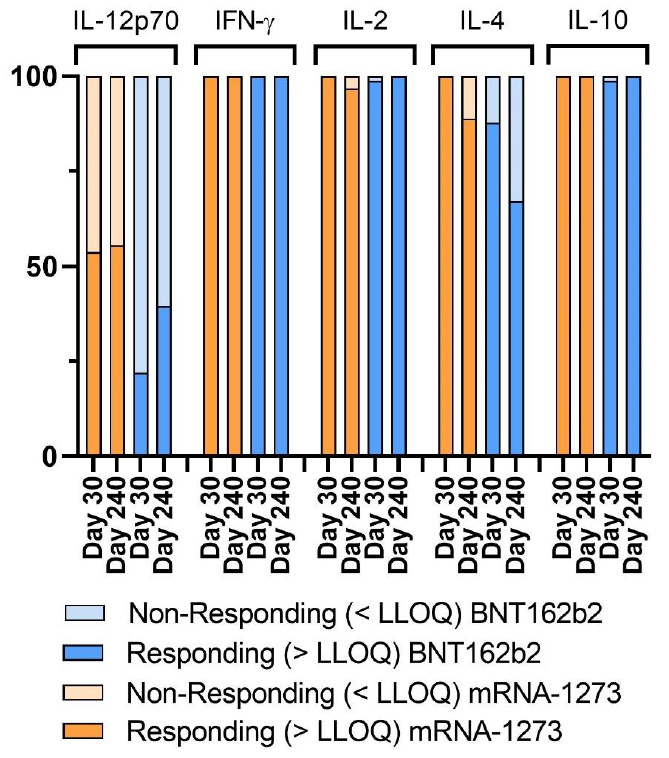
Figure 2. Percentage of responding volunteers reaching the lower limit of detection (LLOD). Bar plot representing the percentage of responding volunteers vaccinated with BNT162b2 (orange) or mRNA-1273 (blue) or non-responding (< LLOD, light orange and light blue, respectively) for the cytokines IL-12p70, IFN- γ , IL-2, IL-4, and IL-10.